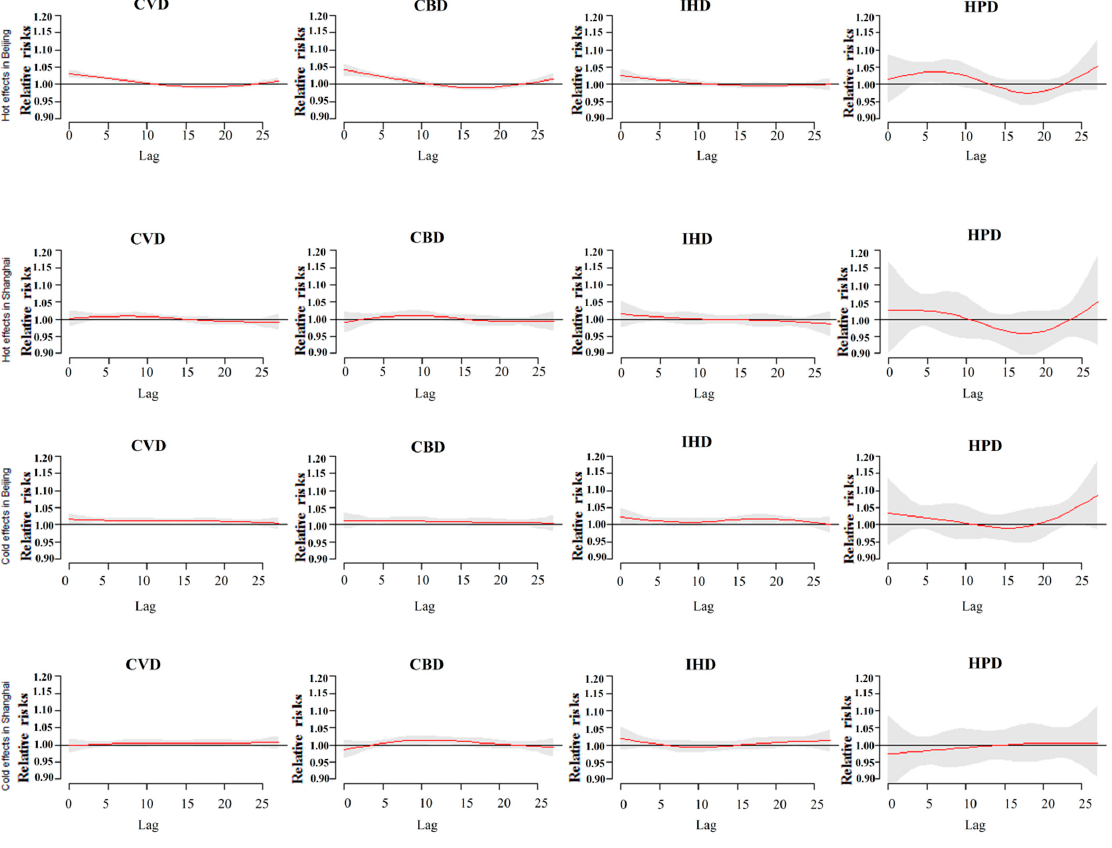
Figure A5. The hot and cold effects on cause-specific cardiovascular mortality along lag days.